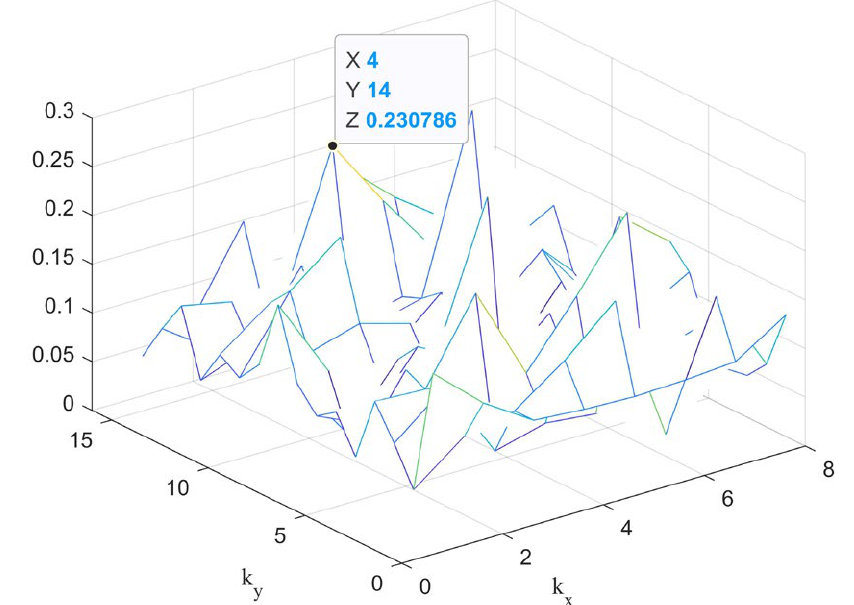
Figure 7. The original angular spectrum.